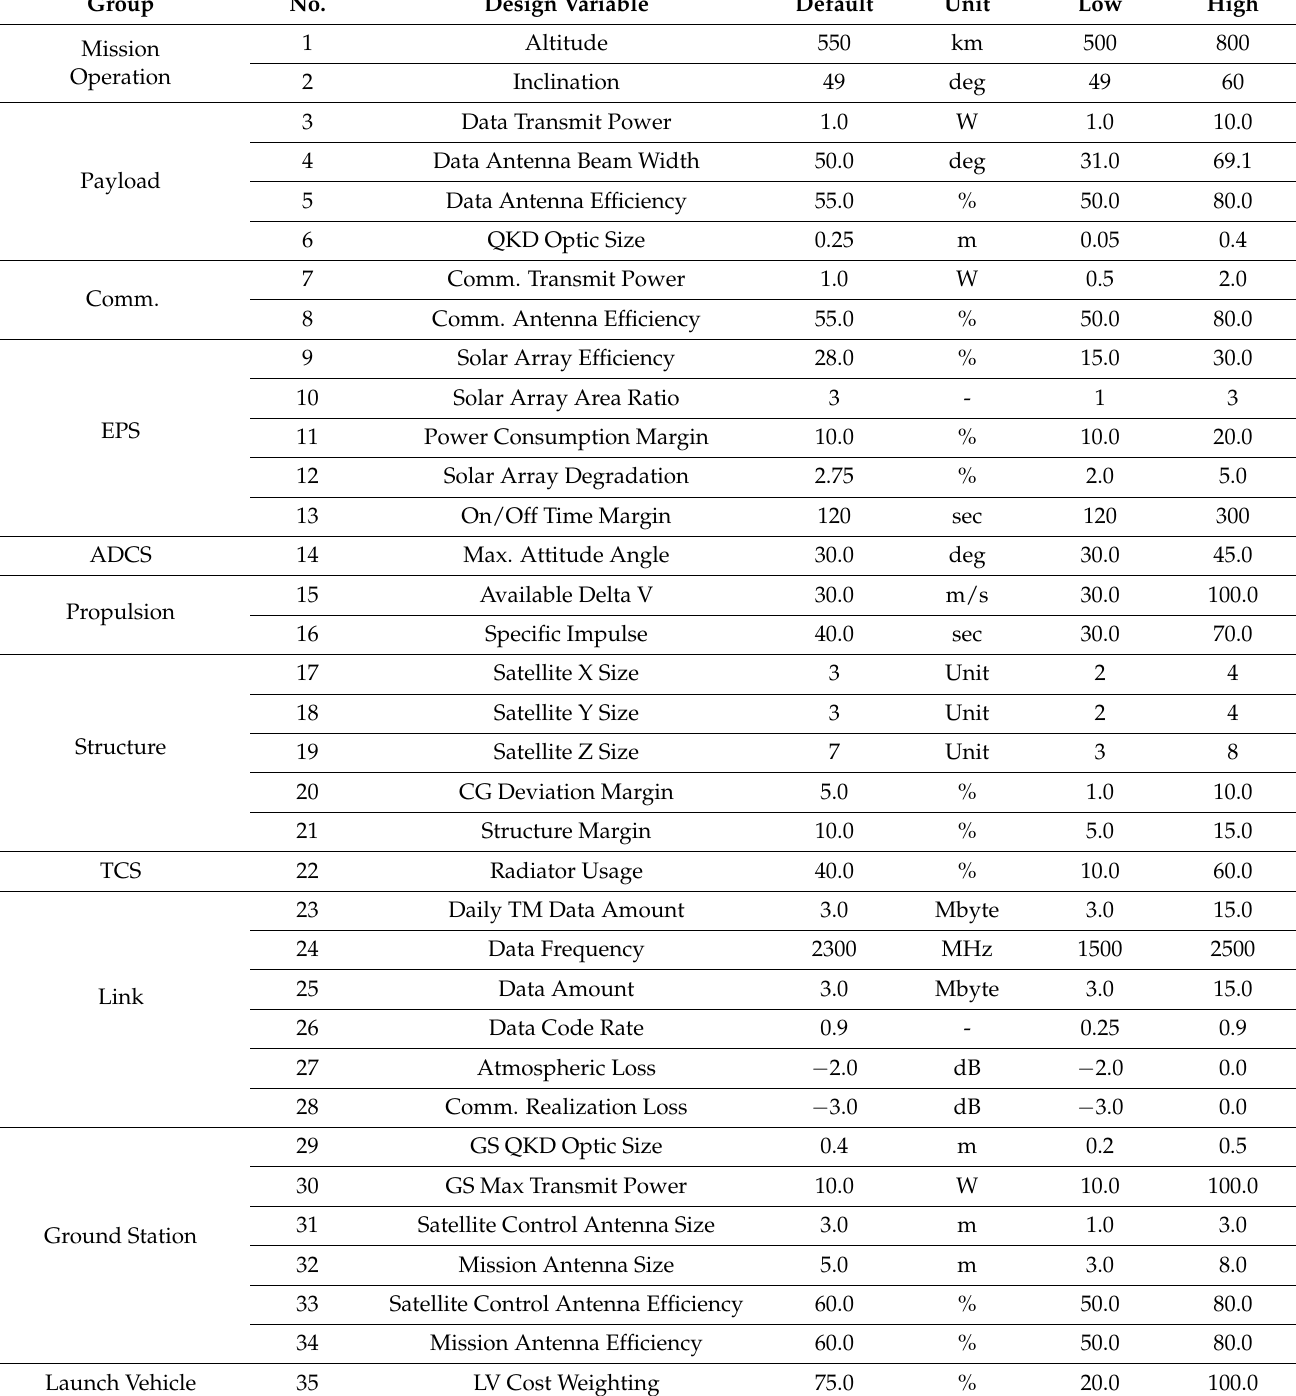
Table 6. Initial draft of chosen design